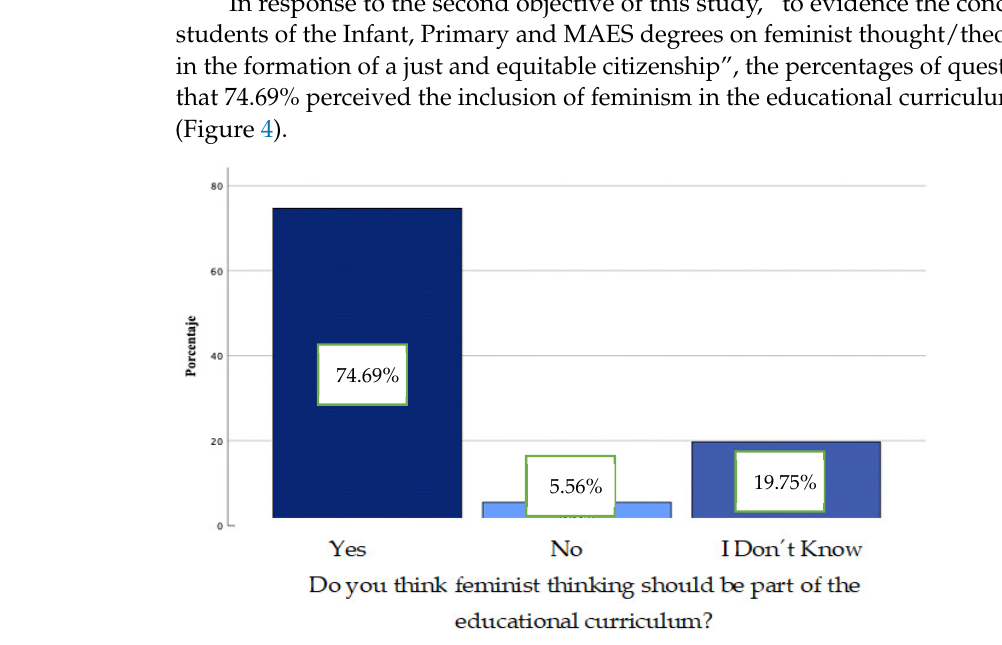
Figure 4. Contingency graph. Question 5.